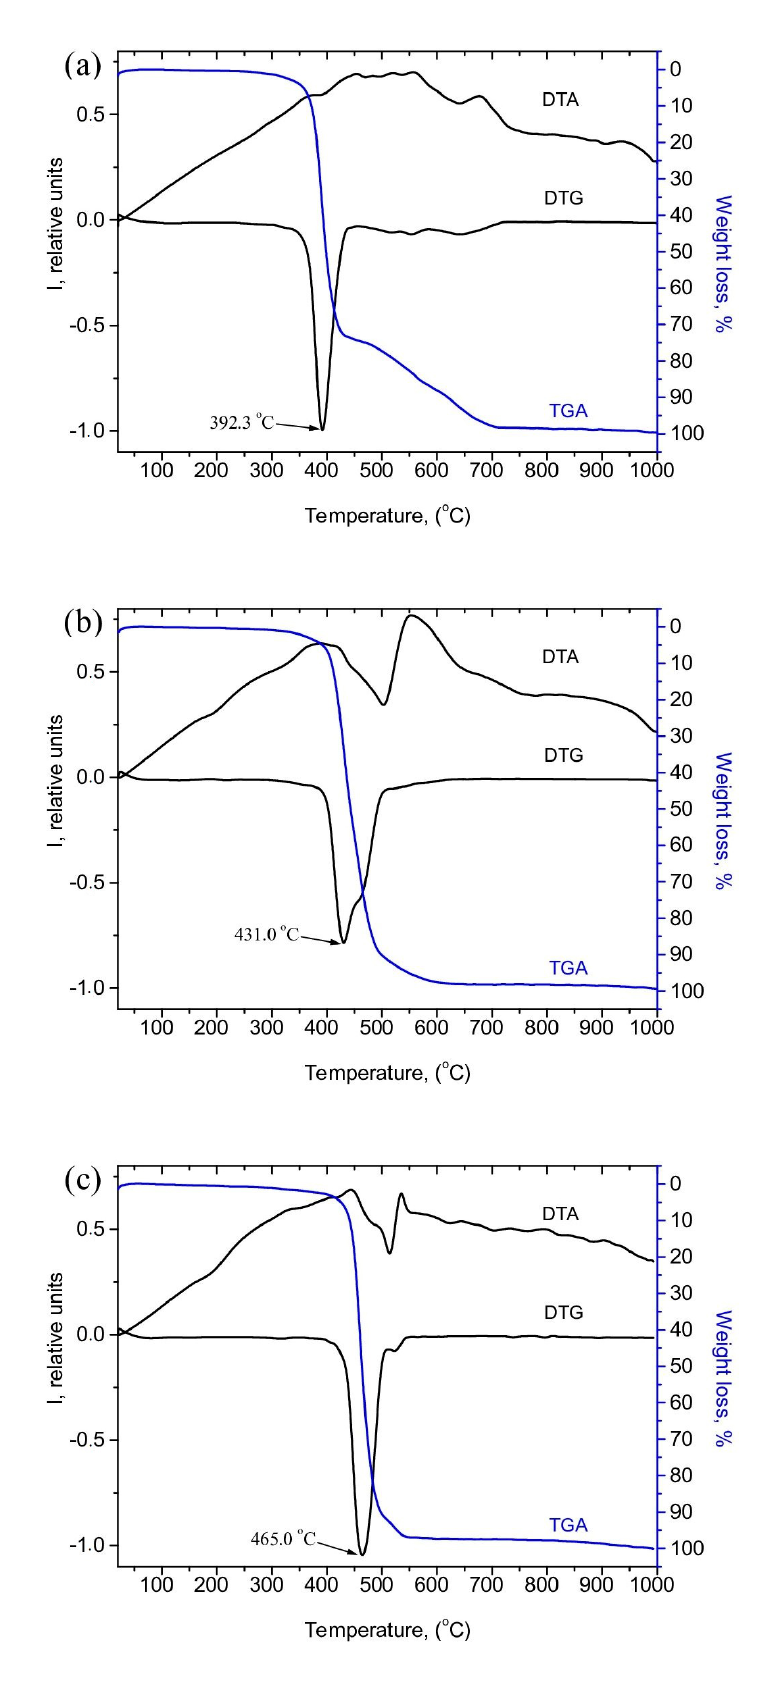
Figure 2. TGA curves in air of: PHMG-NS ( a ); PA-11 ( b ); and PA-11 / PHMH-NS (10%) ( c